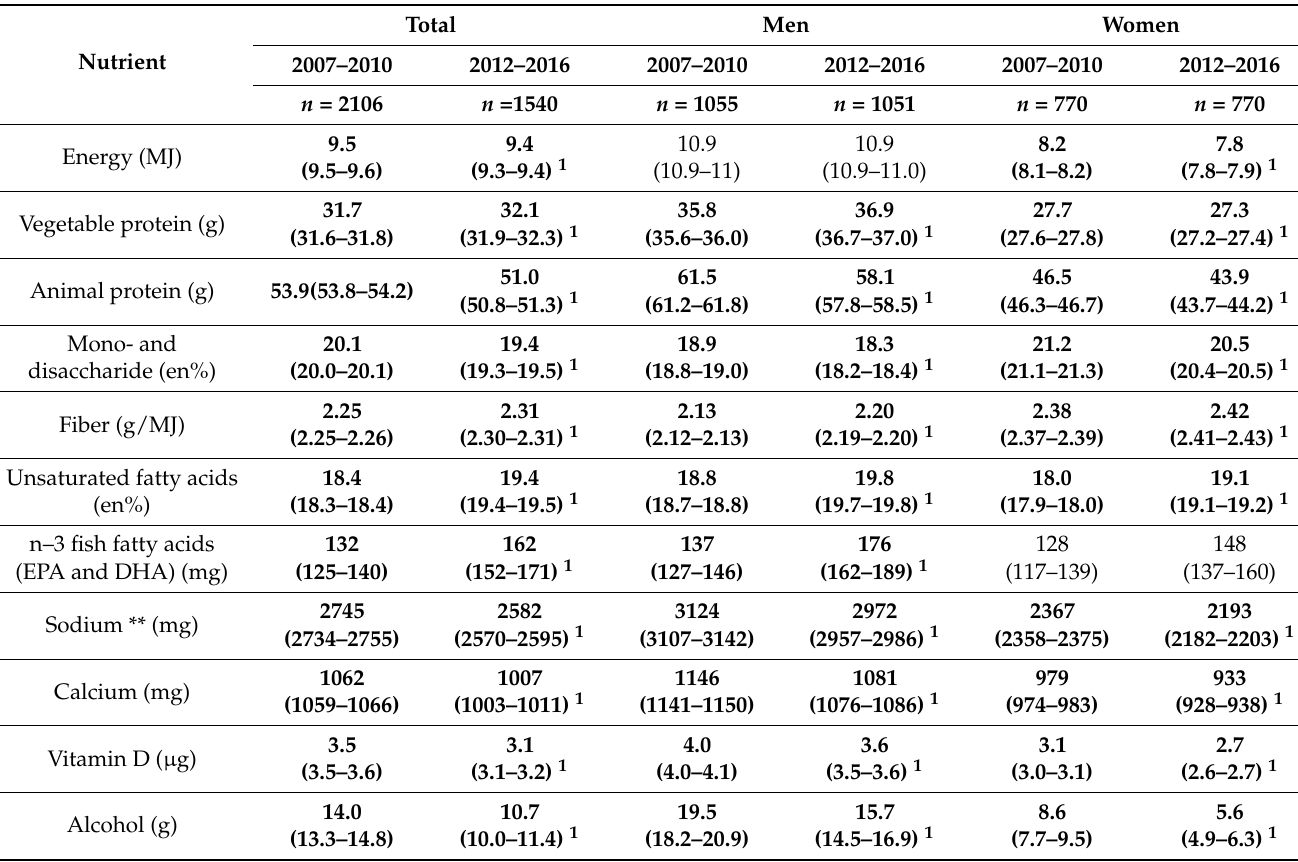
Table 5. Habitual mean ¥ (95%CI) * nutrient intake per day from food sources only for Dutch adults aged 19–69 years